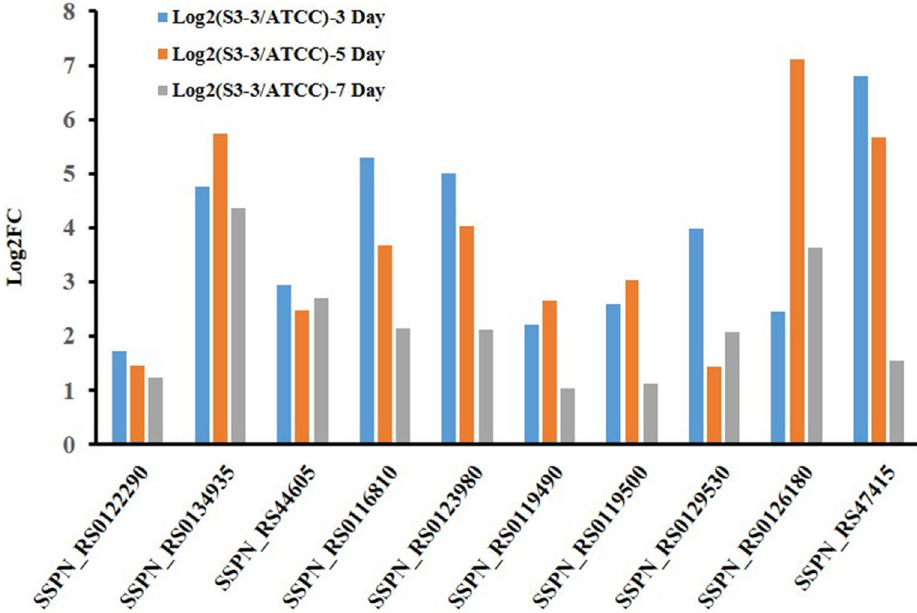
Figure 6. Transcriptional analysis of the genes related to fatty acid metabolism pathway. The expression level of genes in S. spinosa ATCC_49460 was set as 1. (The chart was carried out using Microsoft Office Professional Plus